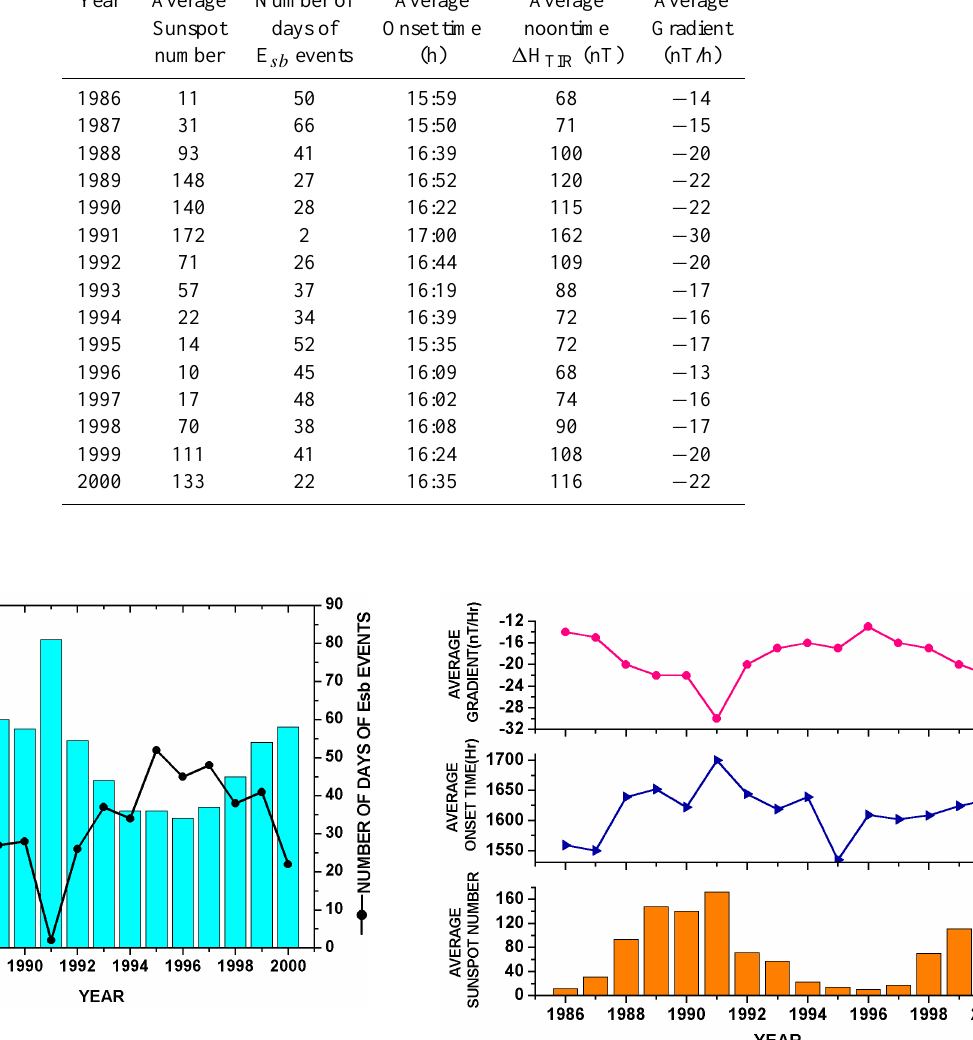
Fig. 5. Variation in the number of E sb events during the solstitial months with the average noontime maximum 1 H TIR during those days (with Ap ≤ 15). Fig. 6. Top panel: Distribution of the most probable values of the